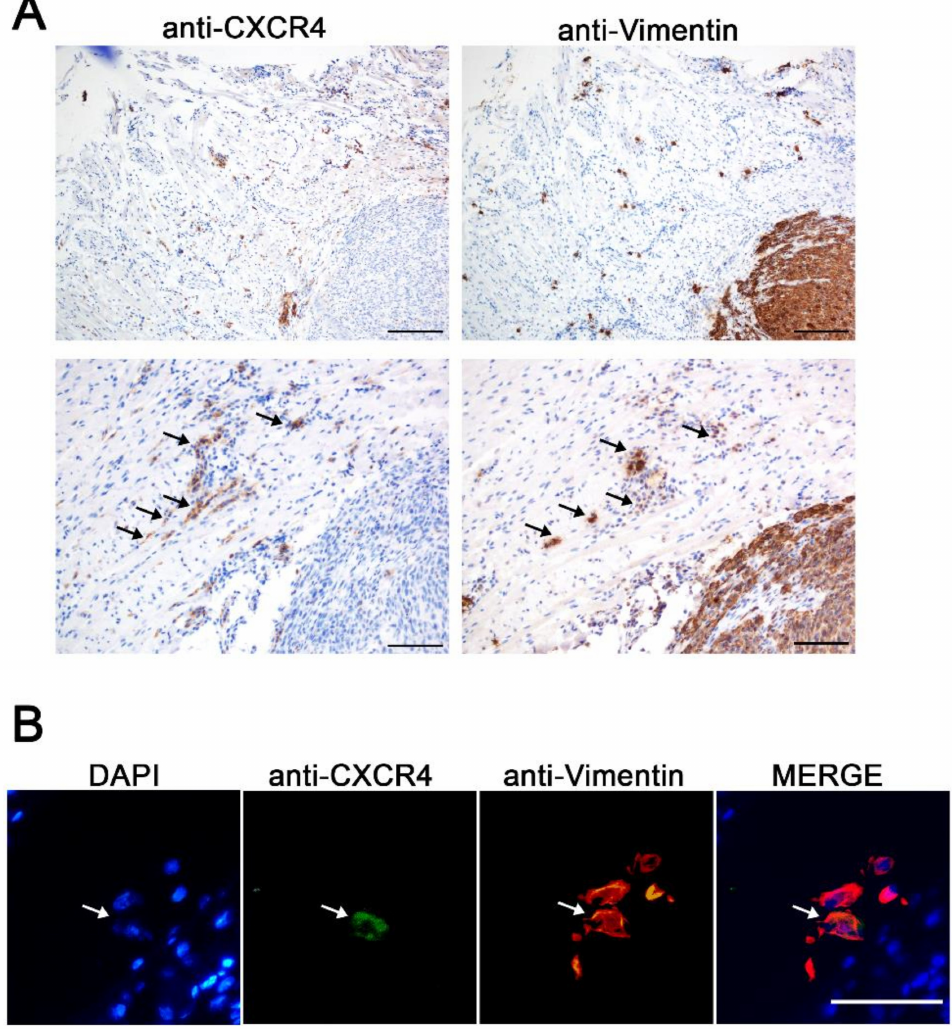
Figure 1. CXCR4 expression in the tumor invasive front generated in the HNSCC orthotopic mouse model. ( A ) Representative CXCR4 and human-vimentin IHC images of the tumor budding showing the presence of CXCR4 + cancer cells invading the surrounding tissue. Scale bars = 200 µ m and 100 µ m. ( B ) CXCR4 and human-vimentin immunofluorescence staining in the invasive front of the orthotopic tumor samples. Scale bars = 50 µ